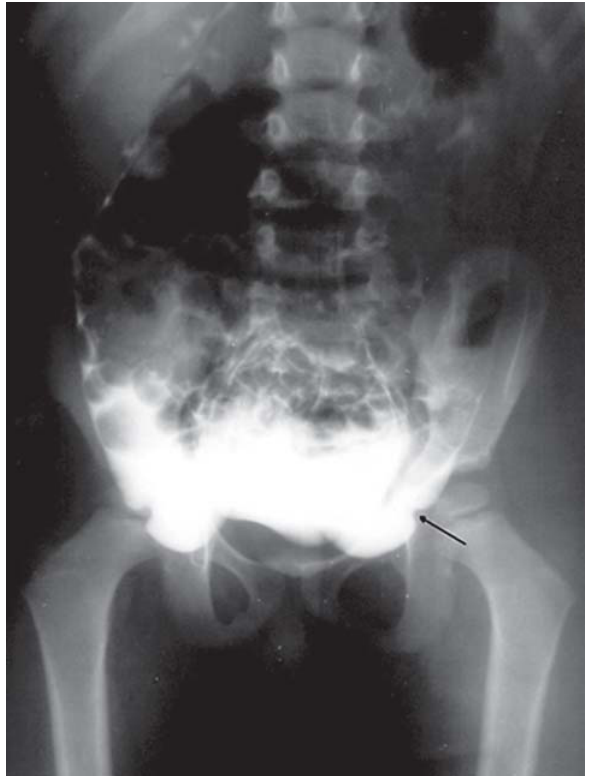
Figure 1 – Peritoneography. After intraperitoneal injection of contrast medium, anteroposterior pelvis X-ray shows no evidence of fissures or irregularities in the peritoneum medial or lateral to the epigastric notch (arrow), and no evidence of the presence of contrast medium below the